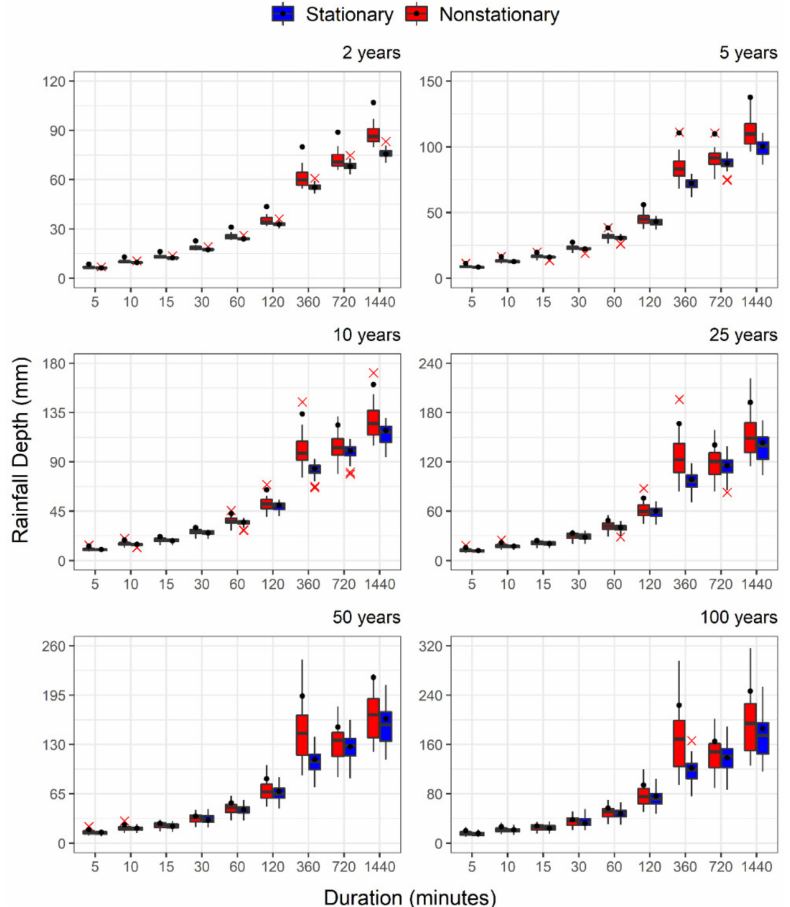
Figure 7. Rainfall depth estimation for different return periods and GCM models for the Shearwater station (RCP 8.5 emission scenario). Black point represents the rainfall depth estimated with the multimodel median ensemble. Red x represents the models in which results produce outliers.